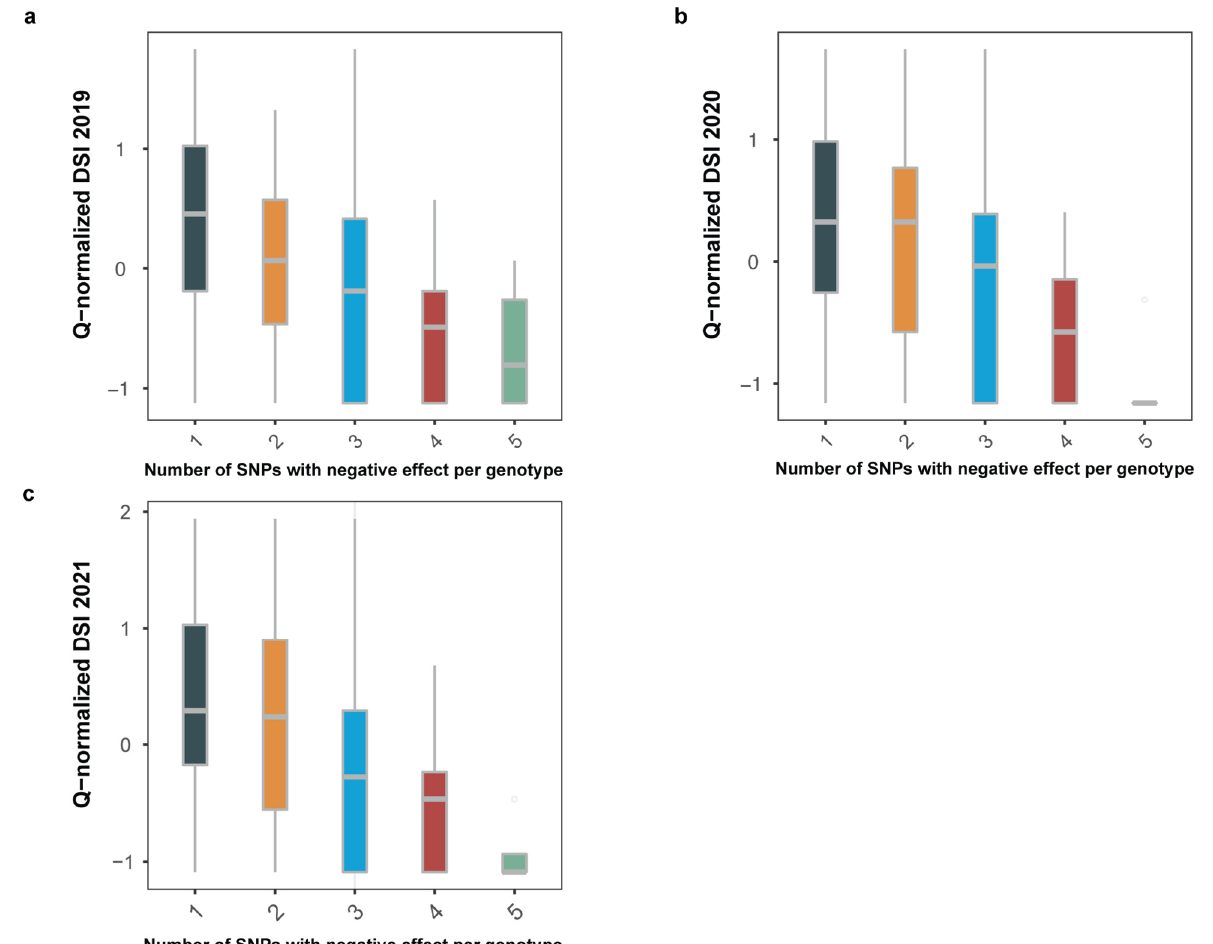
Figure 4. The DSI index value in accessions with different number of QTNs with negative-effect alleles across years of experiment, namely ( a ) year 2019, ( b ) year 2020, and ( c ) year 2021.